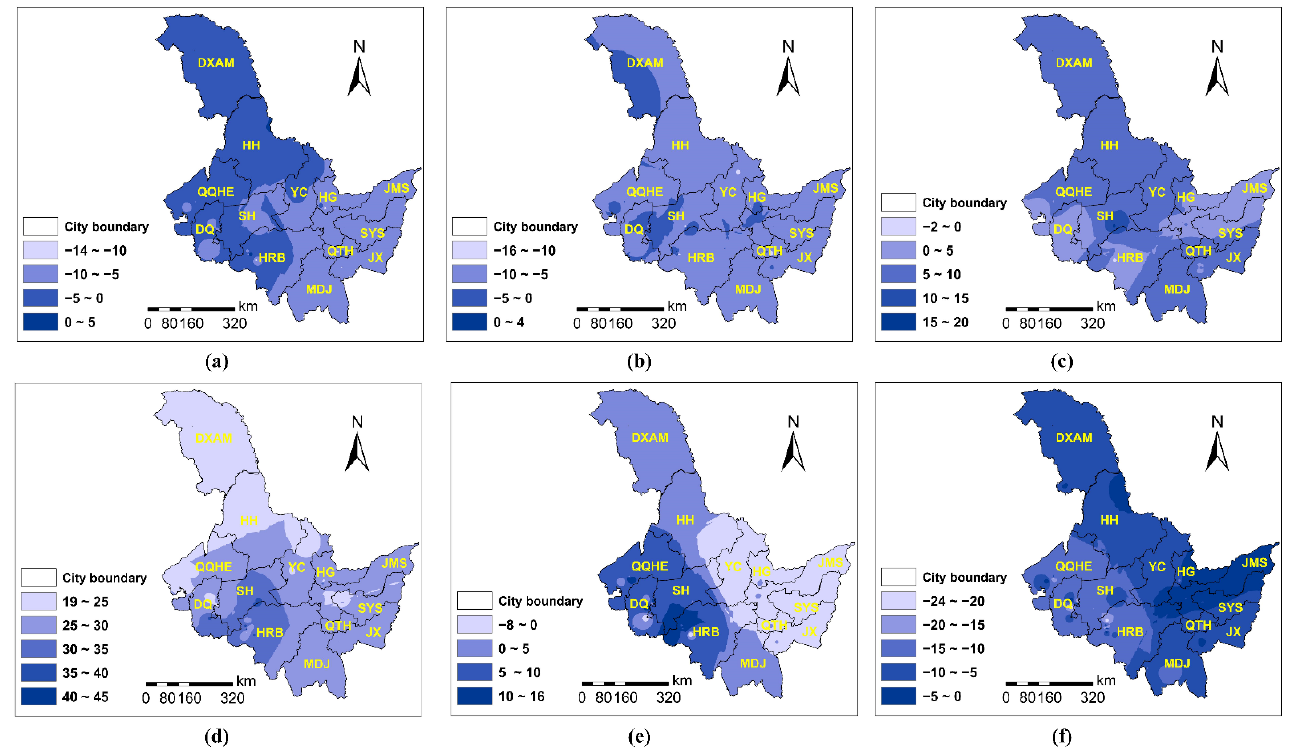
Figure 2. The PCA-GTWR parameter estimates of PM 2.5 interpolated by Inverse Distance Weighted (IDW) method: ( a ) PC1 (temperature); ( b ) PC2 (wind speed); ( c ) PC3 (pressure); ( d ) PC4 (atmos-